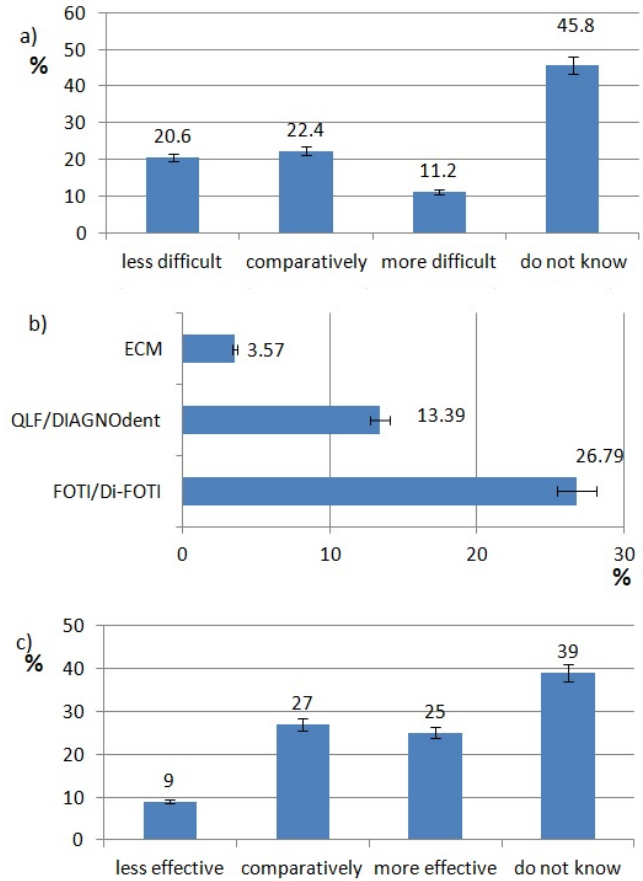
Figure 6. Caries diagnostics methods use pat tern of responding dentists; ( a ) use of each method, ( b ) difficulty of caries diagnostics methods, ( c ) effectiveness of caries diagnostics methods.